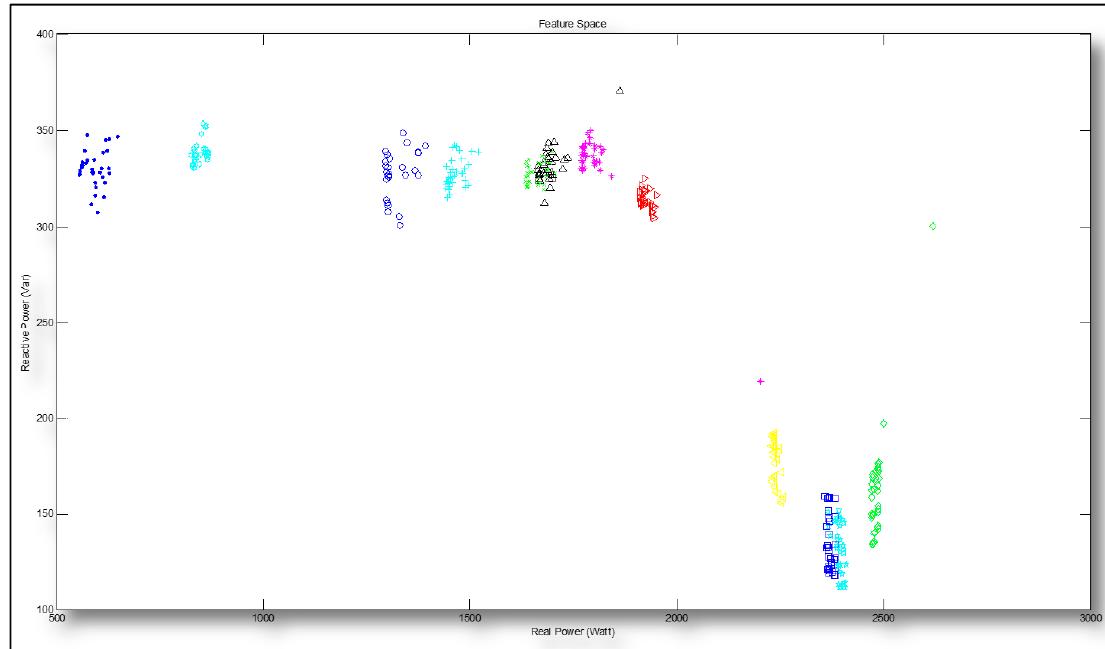
Figure 8. Treated whole feature space being of extracted electrical features ‘P’ and ‘Q’. Table 2. Parameters used by the PSO for the ANN in this paper.